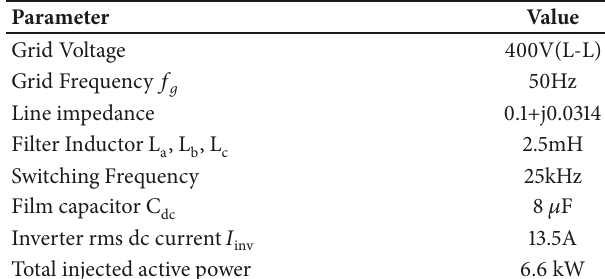
Table 3: Data used in the Simulink model.